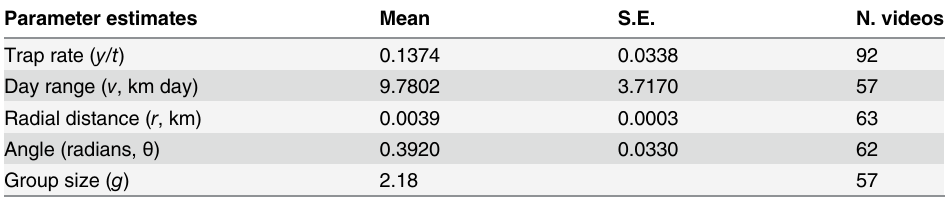
Table 2. Parameter estimates for S . blouchi included in the